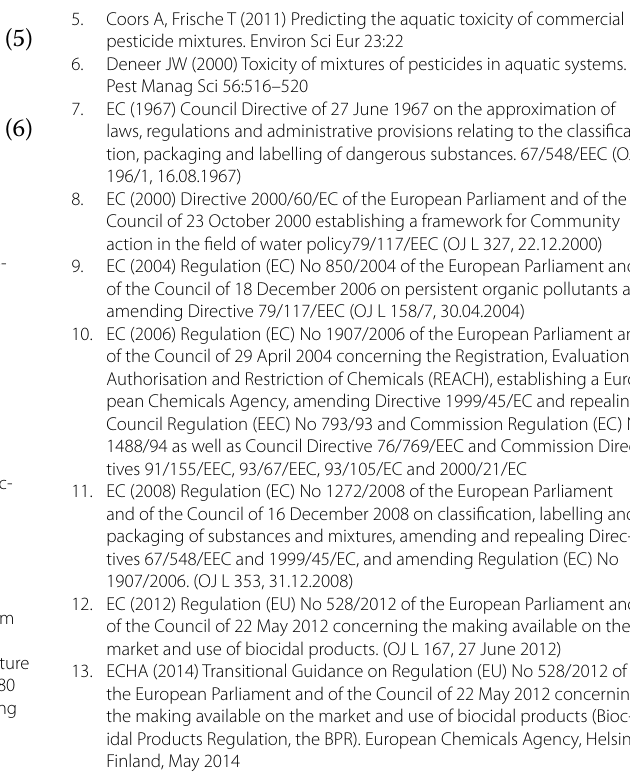
Table 4 Calculation of the predicted EC tions (nominal concentrations) and calculation of the observed and predicted EC